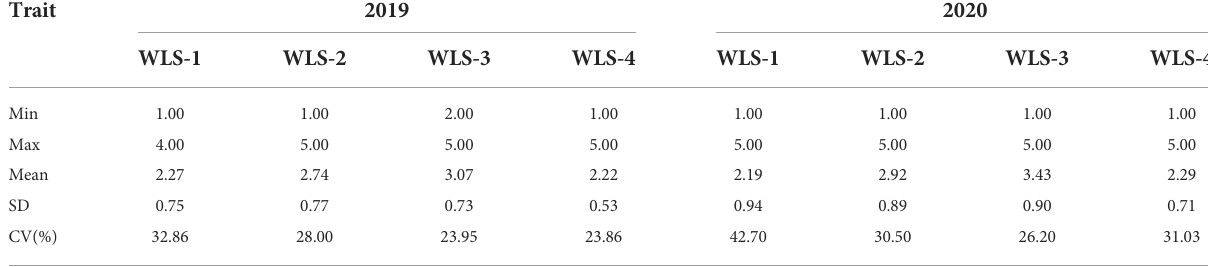
TABLE 1 Phenotypic variation of barley plants under waterlogging stress.